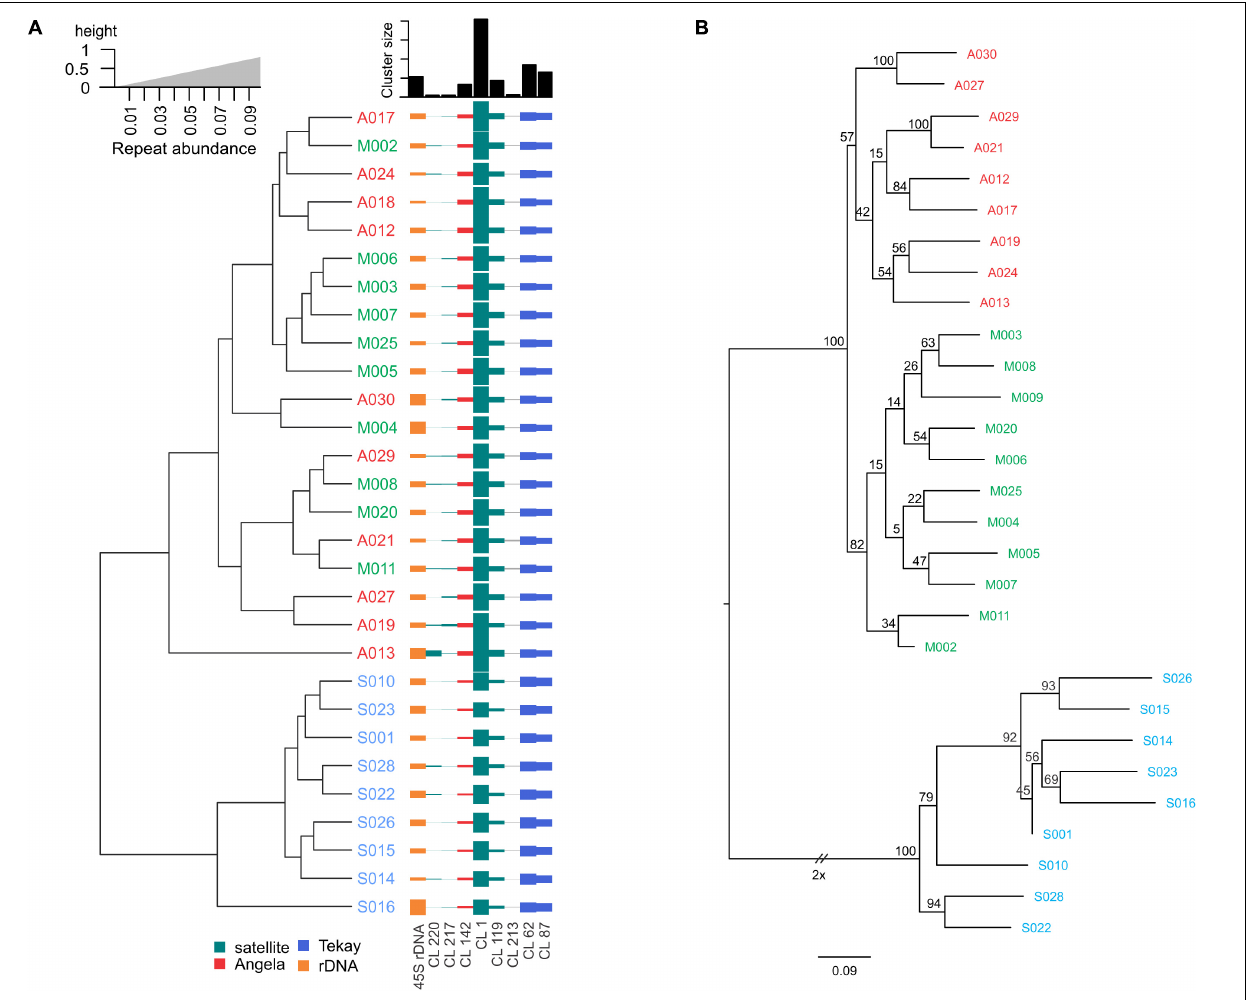
FIGURE 2 | (A) Dendrogram of 29 Ae. tauschii accessions derived from the abundance of repetitive sequences differentially amplified between genotypes and subspecies as inferred from RepeatExplorer2. (B) Phylogenetic tree by maximum likelihood method based on SNPs discovered from low coverage Illumina reads. Numbers at the nodes are bootstrap values from 100 replications. Accession codes have been shown in red (for subsp. anathera ), green (subsp. meyeri ), and blue (subsp. strangulata